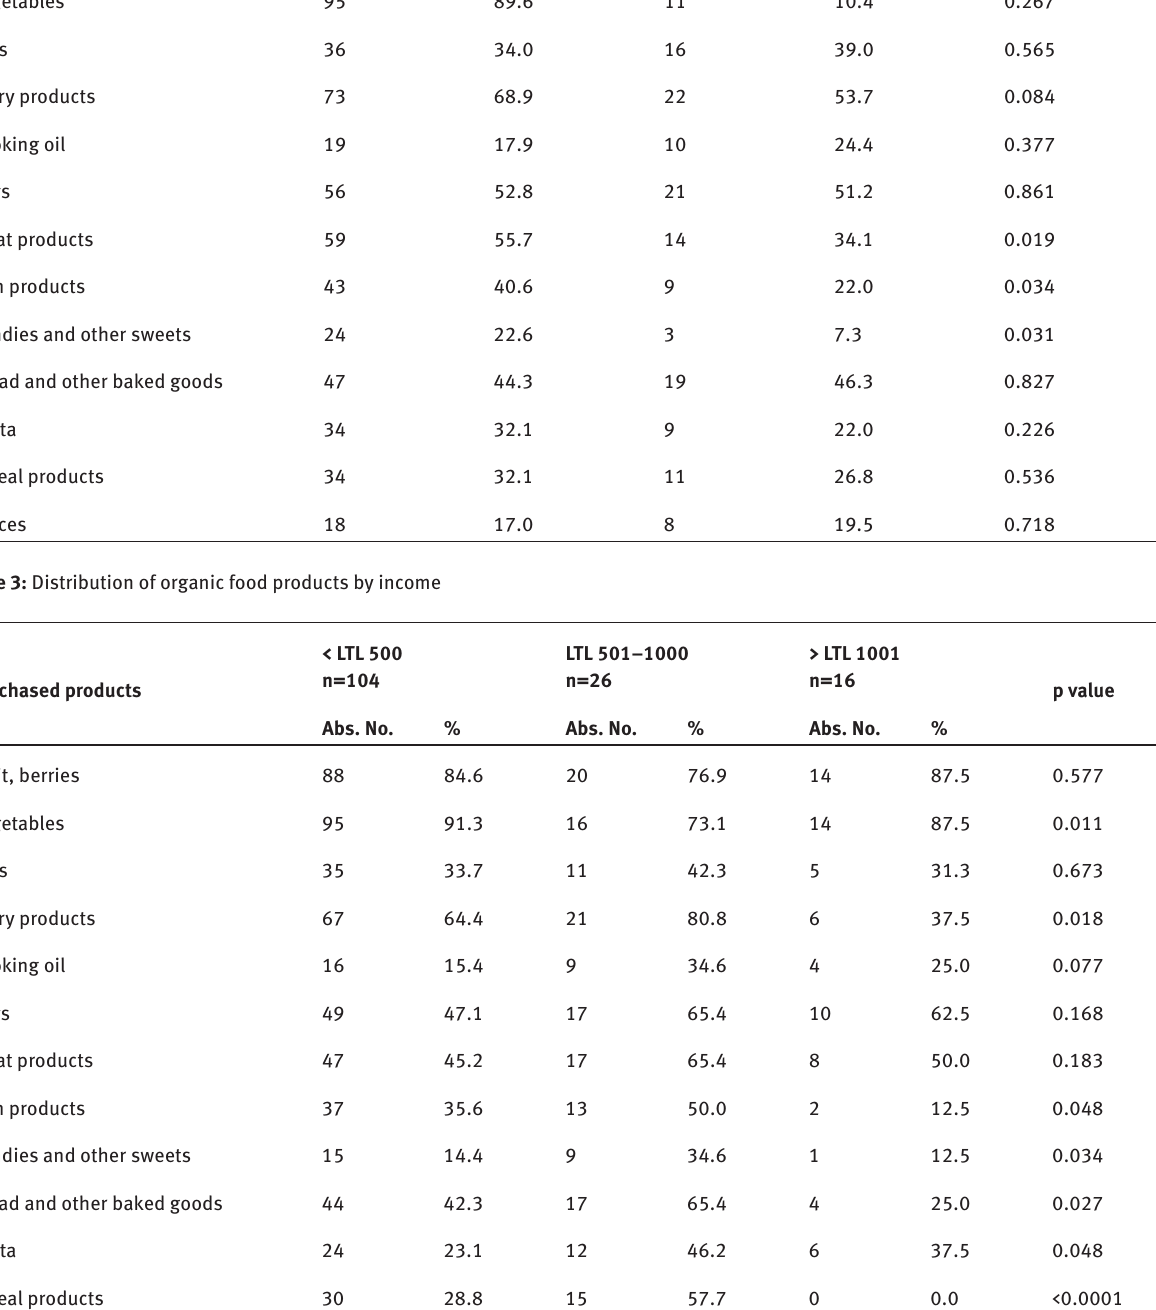
Table 2: Distribution of organic food products by gender